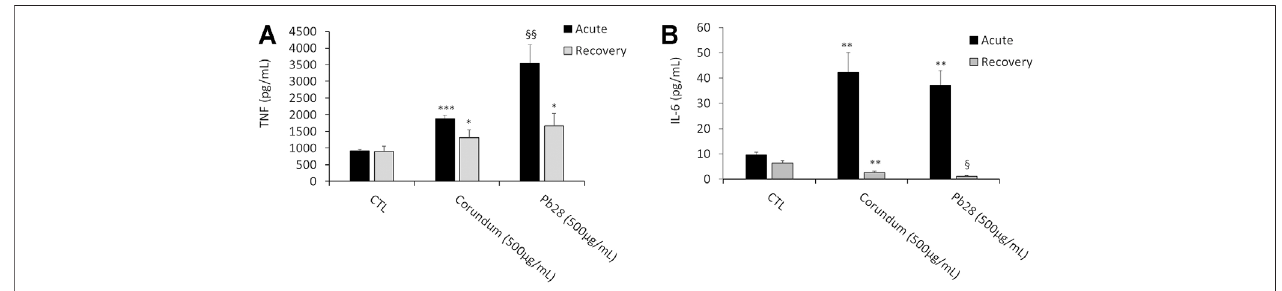
FIGURE9| Pro-in fl ammatorycytokines secretion. Blackbars;acute exposure(lastday ofculture (cid:1) 24 h).Greybars; recoveryexposure( fi rstday ofculture (cid:1) 24 h) and 9 days recovery post exposure. Data are represented as Mean +SD. Panel A- TNF secretion without LPS stimulation. Panel B- IL-6 secretion without LPS stimulation. Signi fi cance symbols: *, signi fi cant change compared to negative control only (cells without treatment). §, signi fi cant change compared to negative control and corundum control (same concentration). Number of symbols: 1: p < 0.05, 2: p < 0.01, 3: p < 0.001 (Student t test, N (cid:1) 3).